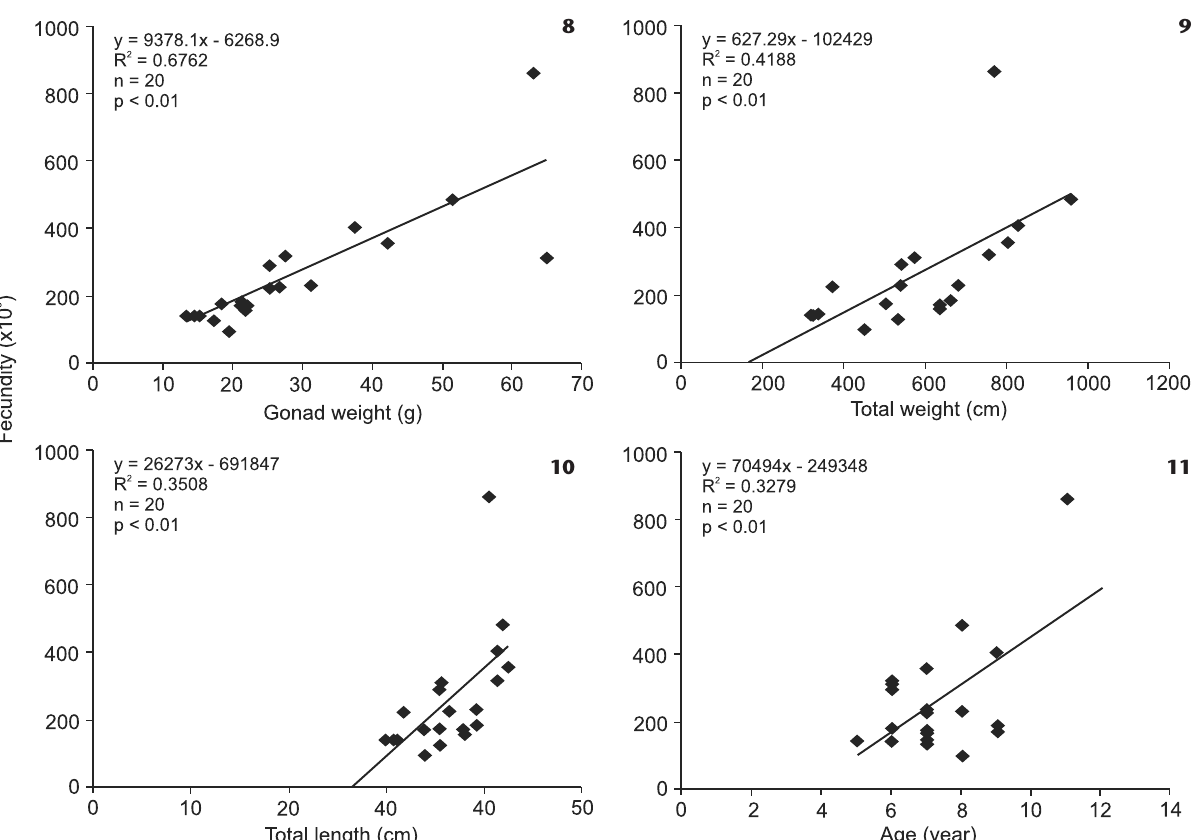
Figures 8-11. Relationship between batch fecundity and gonad weight (8), total weight (9), total length (10), and age (11) of Cynoscion leiarchus in Sepetiba